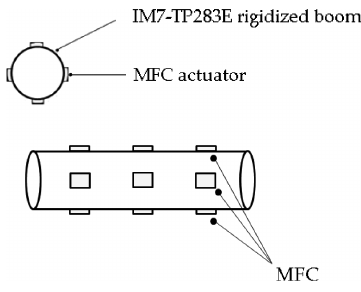
Fig. 3. Schematic of an in fl atable boom and attached MFC.